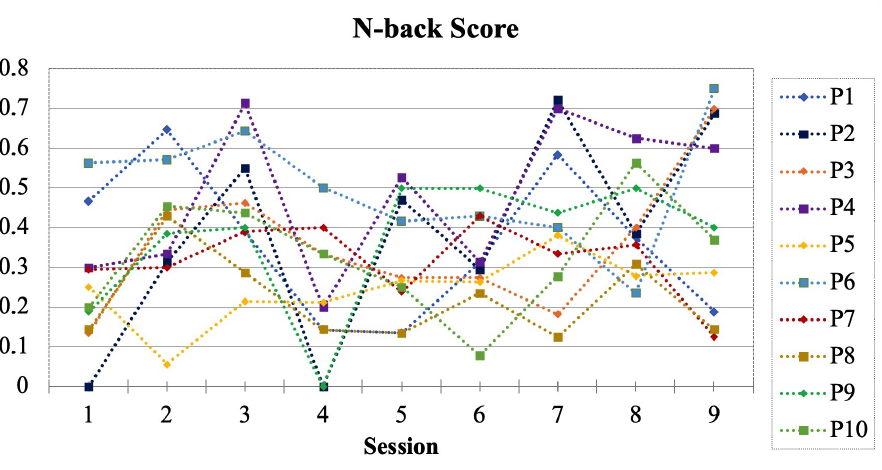
Figure 8. The N-back score of the 10 participants. A clear drop during sessions 4–6 (double 3-back) is visible.